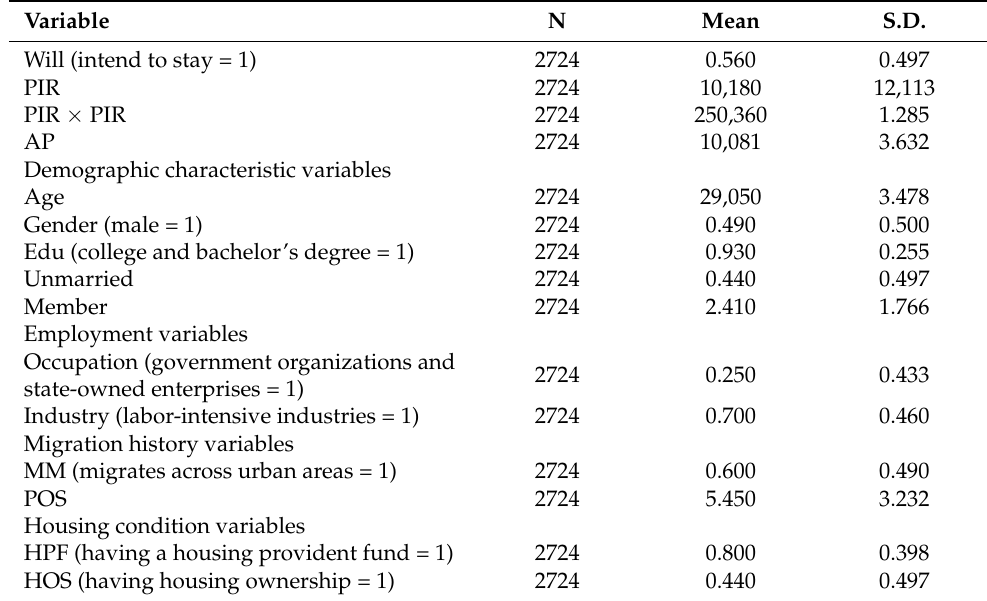
Table 1. Statistical description of